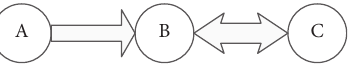
Figure 2: Directed connection